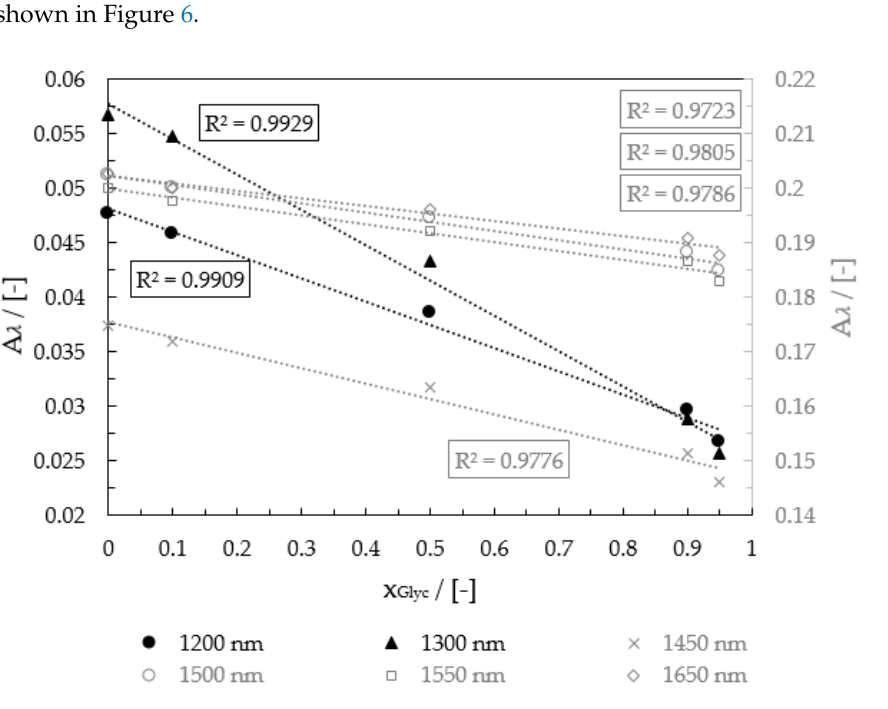
Figure 6. Calibration curves in absorption for a pixel at 20 °C, 30 °C, and 40 °C.